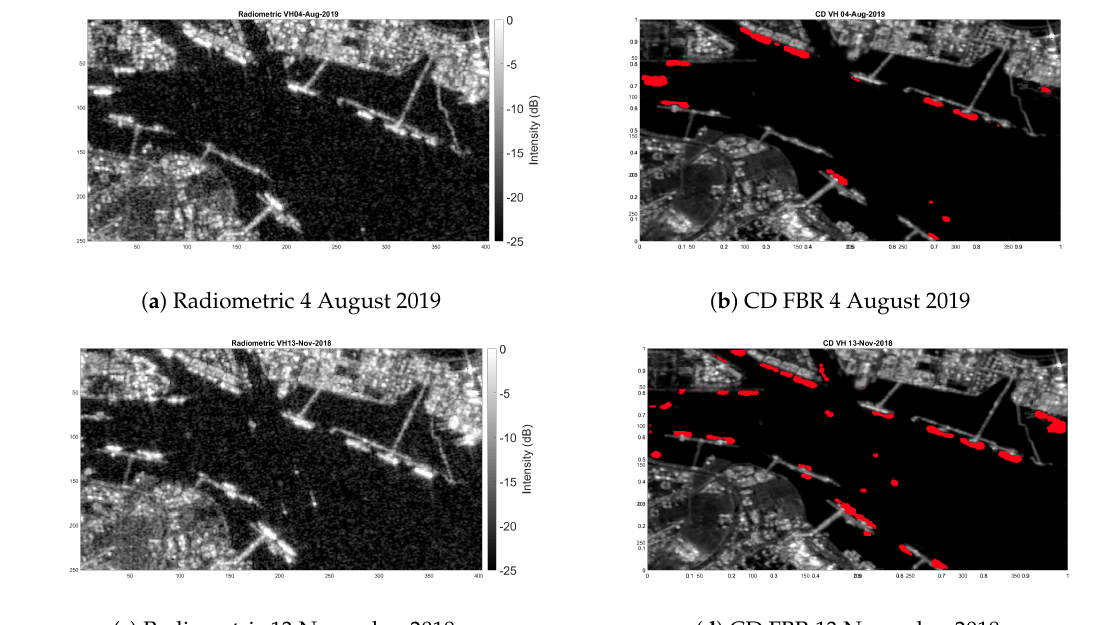
Figure 20. Images of highest and lowest attendance detected with the FBR method: ( a ) Radiometric 4 August 2019, ( b ) CD FBR 4 August 2019, ( c ) Radiometric 13 November 2018 and ( d ) CD FBR 13 November